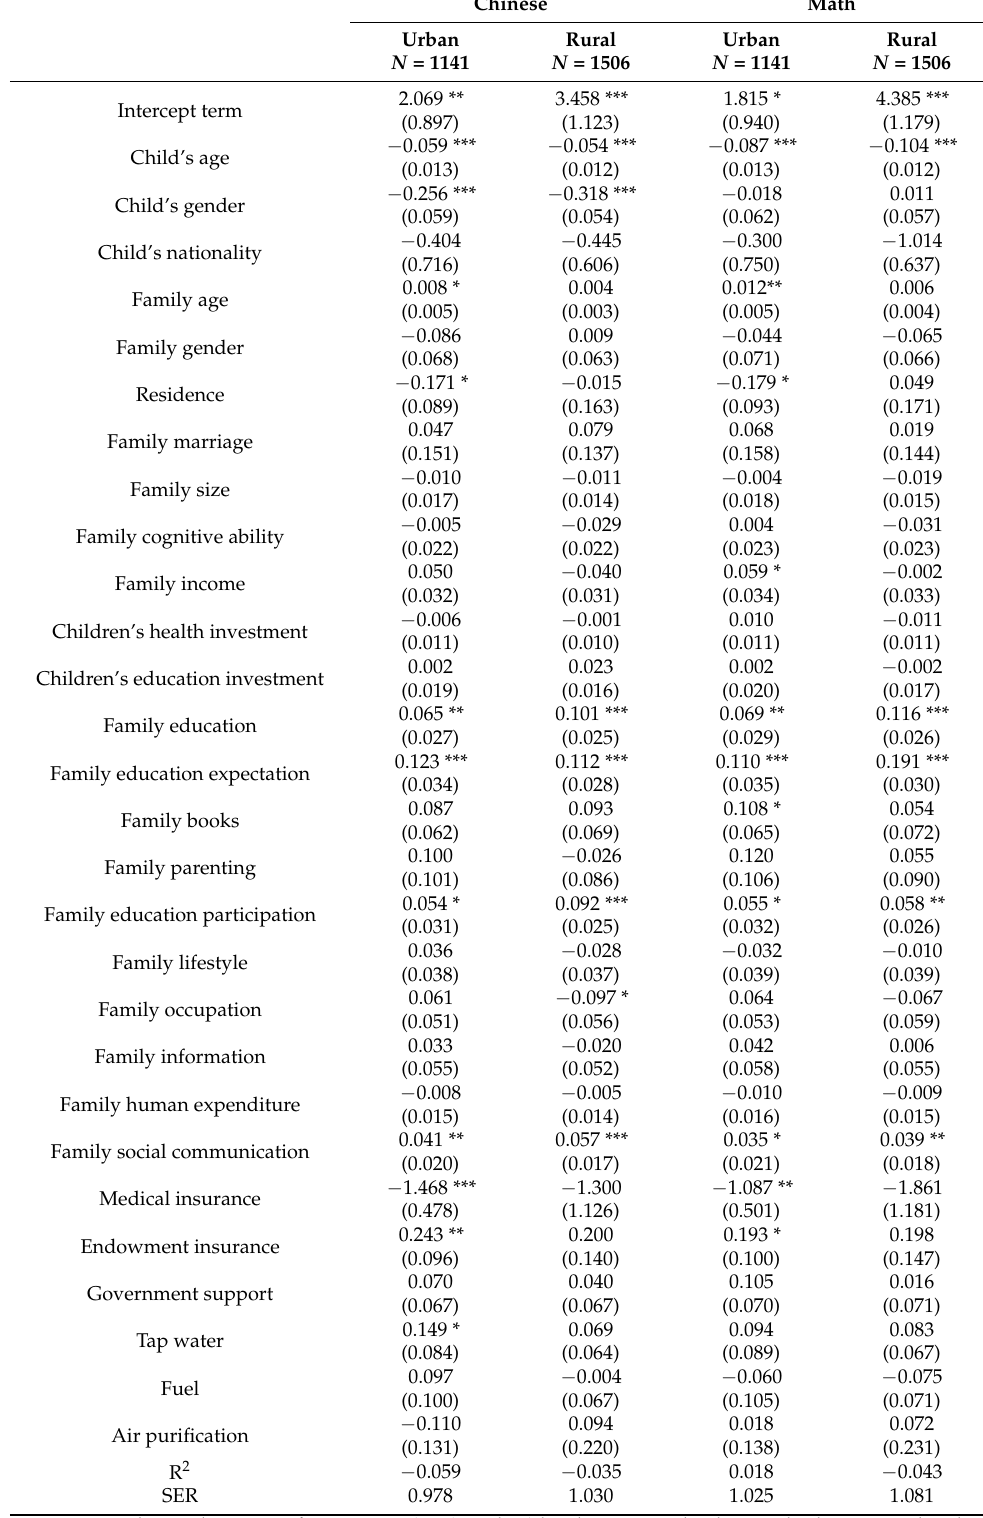
Table A3. Results for two-stage least squares by urban